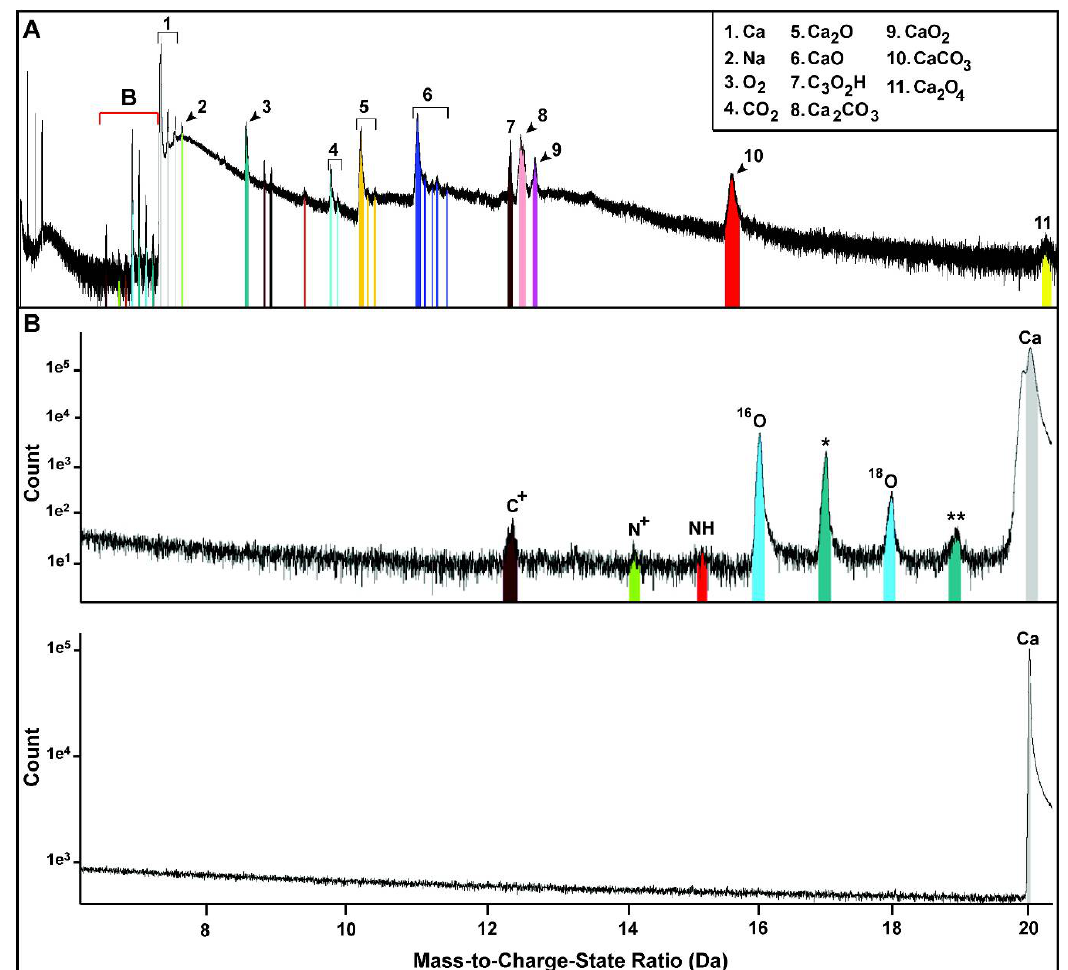
Figure 3. APT mass-to-charge ratio spectra chemical data. ( A ) Example of a mass spectrum ( x -axis: mass-to-charge ratio and y -axis: ion count—please note that units are not relevant in this case and have been deleted for figure clarity) corresponding to tip 269 (see Table 1), with the identification of major peaks; ( B ) Comparison of the partial spectrum (between 11 Da and 21 Da) for tip 269 (region B in top figure) and abiogenic calcite (bottom figure; adapted from Pérez-Huerta et al., [17]). Note the presence of single ion peaks for 12 C (12 Da), 16 O (16 Da), 16 O + H + (*; 17 Da), 18 O (18 Da), and 18 O + H + (**; 19 Da) specific to the biogenic calcite.